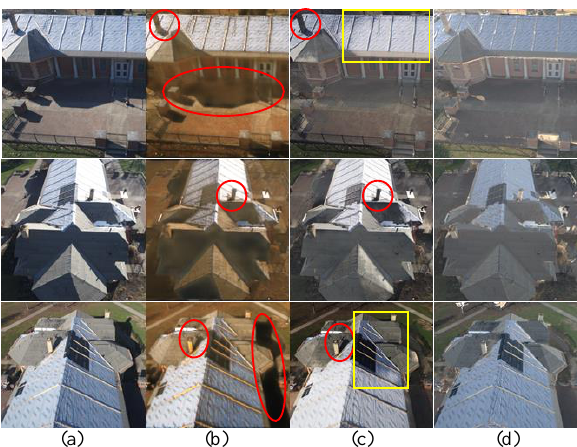
(d) Profiles of (b)